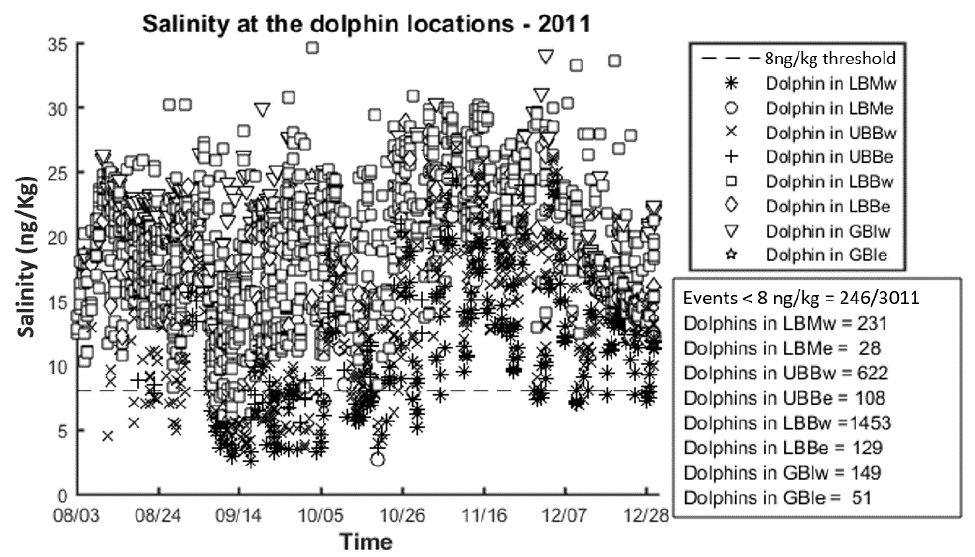
Figure 17. 2011 basin wide salinity model output and dolphin locations over time.